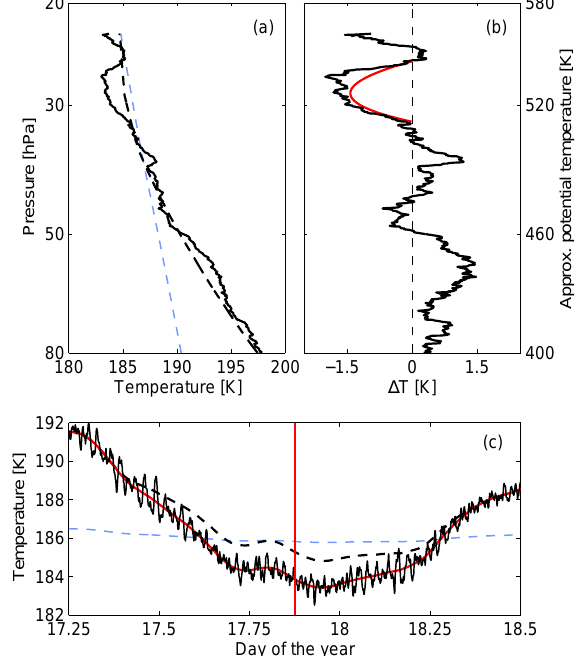
Fig. 2. (a) Black solid line: temperatures measured with the Vaisala RS-92 radiosonde launched from Sodankylä on 17 January 2010 (S1). Black dashed line: ERA-Interim reanalysis temperatures in- terpolated in time and space to the position of the drifting balloon. Blue dashed line: frost point temperature calculated from the cli- matological mean water vapor profile. (b) Difference between mea- surement and ERA-Interim as shown in (a) . Red line: temperature correction applied to the trajectories between 32hPa and 25hPa. (c) Black dashed line: exemplary ERA-Interim trajectory at S1 for 29hPa. Blue dashed line: frost point temperature calculated from the climatological mean water vapor profile. Red solid line: ERA- Interim trajectory with temperature correction. Black solid line: ERA-Interim trajectory with temperature correction and superim- posed small-scale fluctuations. See text for